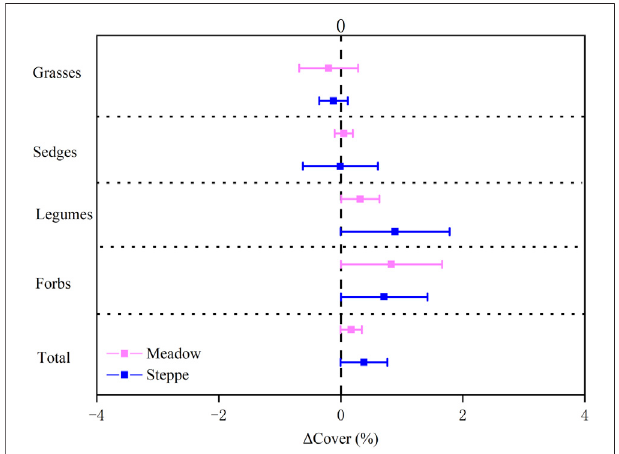
FIGURE 2 | Changes in biomass of grasses, sedges, legumes, forbs, and total biomass in alpine meadow (red) and steppe (blue) from 2008 to 2018 in the permafrost region of the Tibetan Plateau. Relative change rate in aboveground biomass ( Δ Biomass %) was calculated as the ratio of the absolutechange(inunitsofg m − 2 )tothemeanbiomassoverthestudyperiod. Dataare shown asestimate ±95% con fi dence intervals (CI).Datagreaterthan zero represent a signi fi cant increase in the measured variable, and data lower than zero represent a signi fi cant decrease between 2008 and 2018.